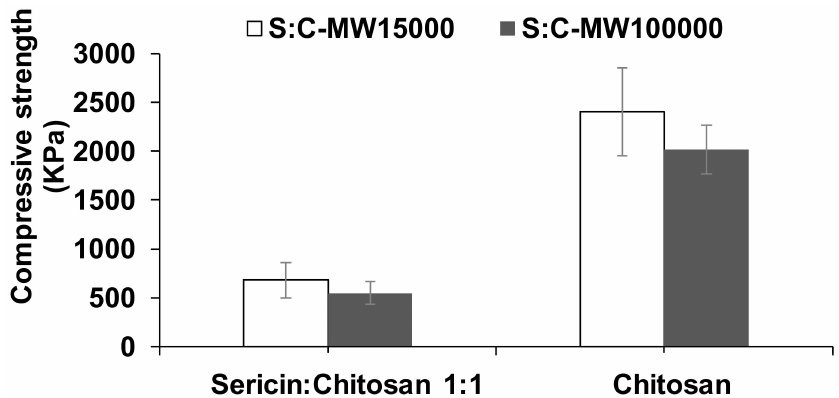
Figure 5. The e ff ect of chitosan MW 15,000 g / mol and 100,000 g / mol on the compressive strength of sericin-chitosan sca ff old at a ratio of 1:1 as compared with pure